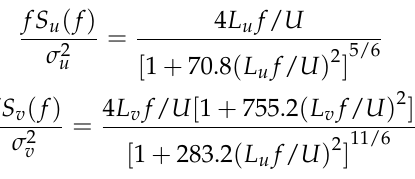
Figure 9. Time history of Leatop Plaza under Typhoon Vicente (origin: 22:30 July 23). 4.2. Structural Dynamic Properties 4.2.1. Method for Modal Analysis The variations in the modal parameters were investigated on the basis of the results obtained using the fast Bayesian FFT approach, which is a frequency-domain method within the Bayesian operational modal analysis framework [26-28]. The fast Bayesian FFT